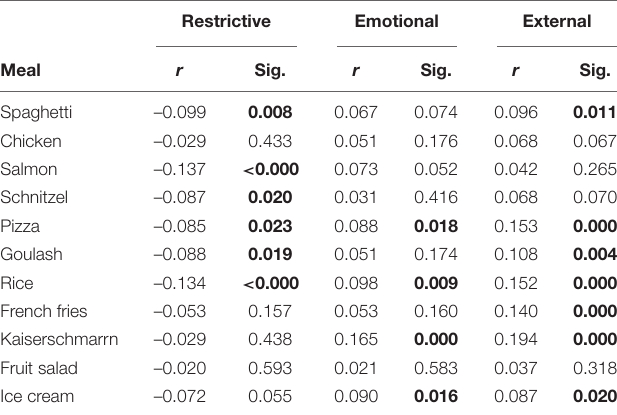
TABLE 3 | Estimations of perfect portion size in different DEBQ categories by partial correlations with the hunger, gender, age, and BMI as control variables. Restrictive Emotional